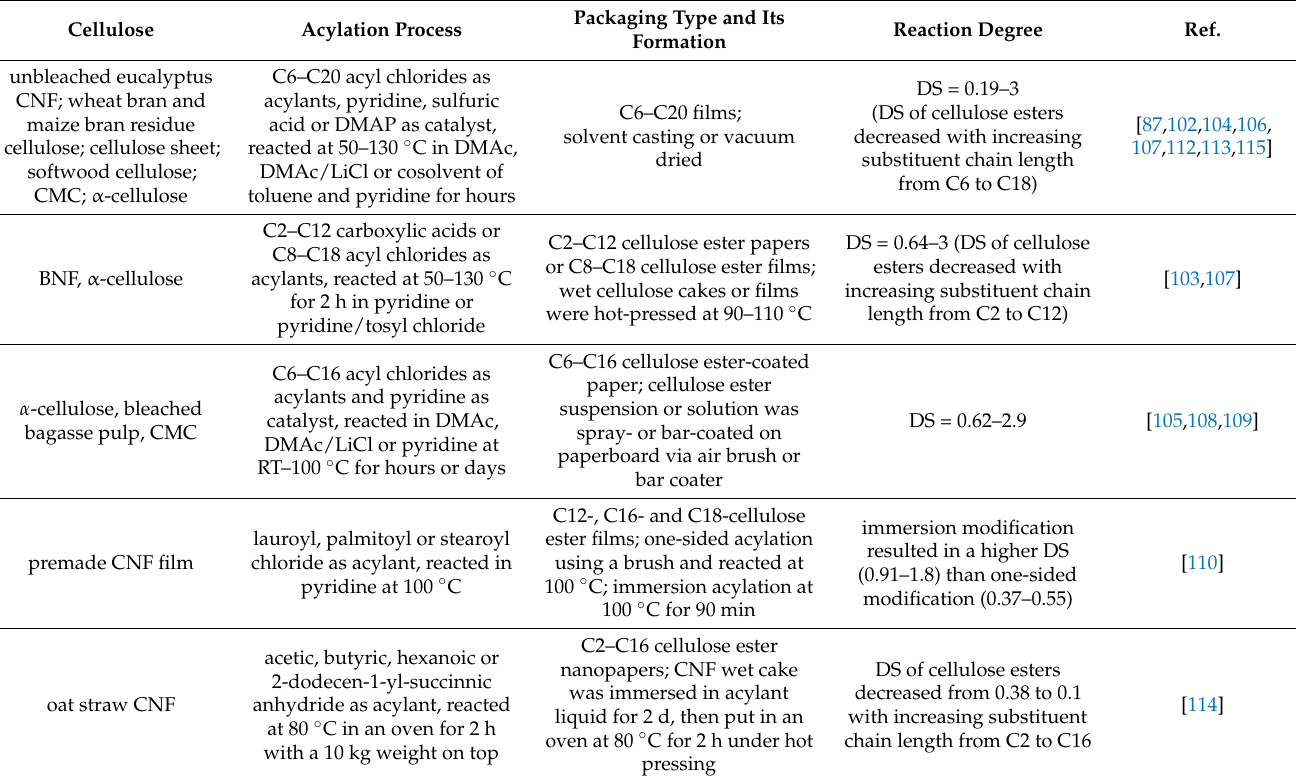
Table 4. Esterification of cellulose using C2–C20 acylants, reaction degree, and the associated packaging forming